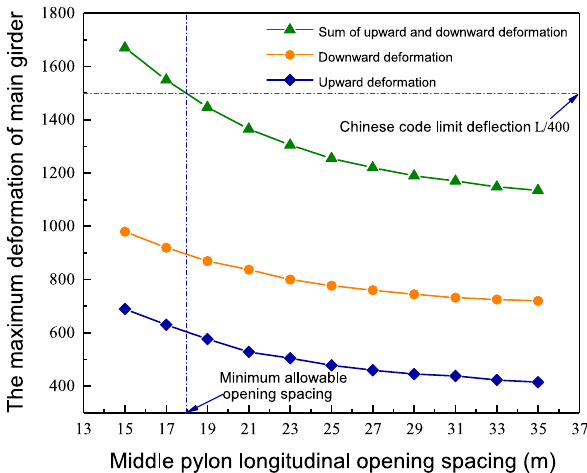
Figure 5. The longitudinal opening spacing of the middle